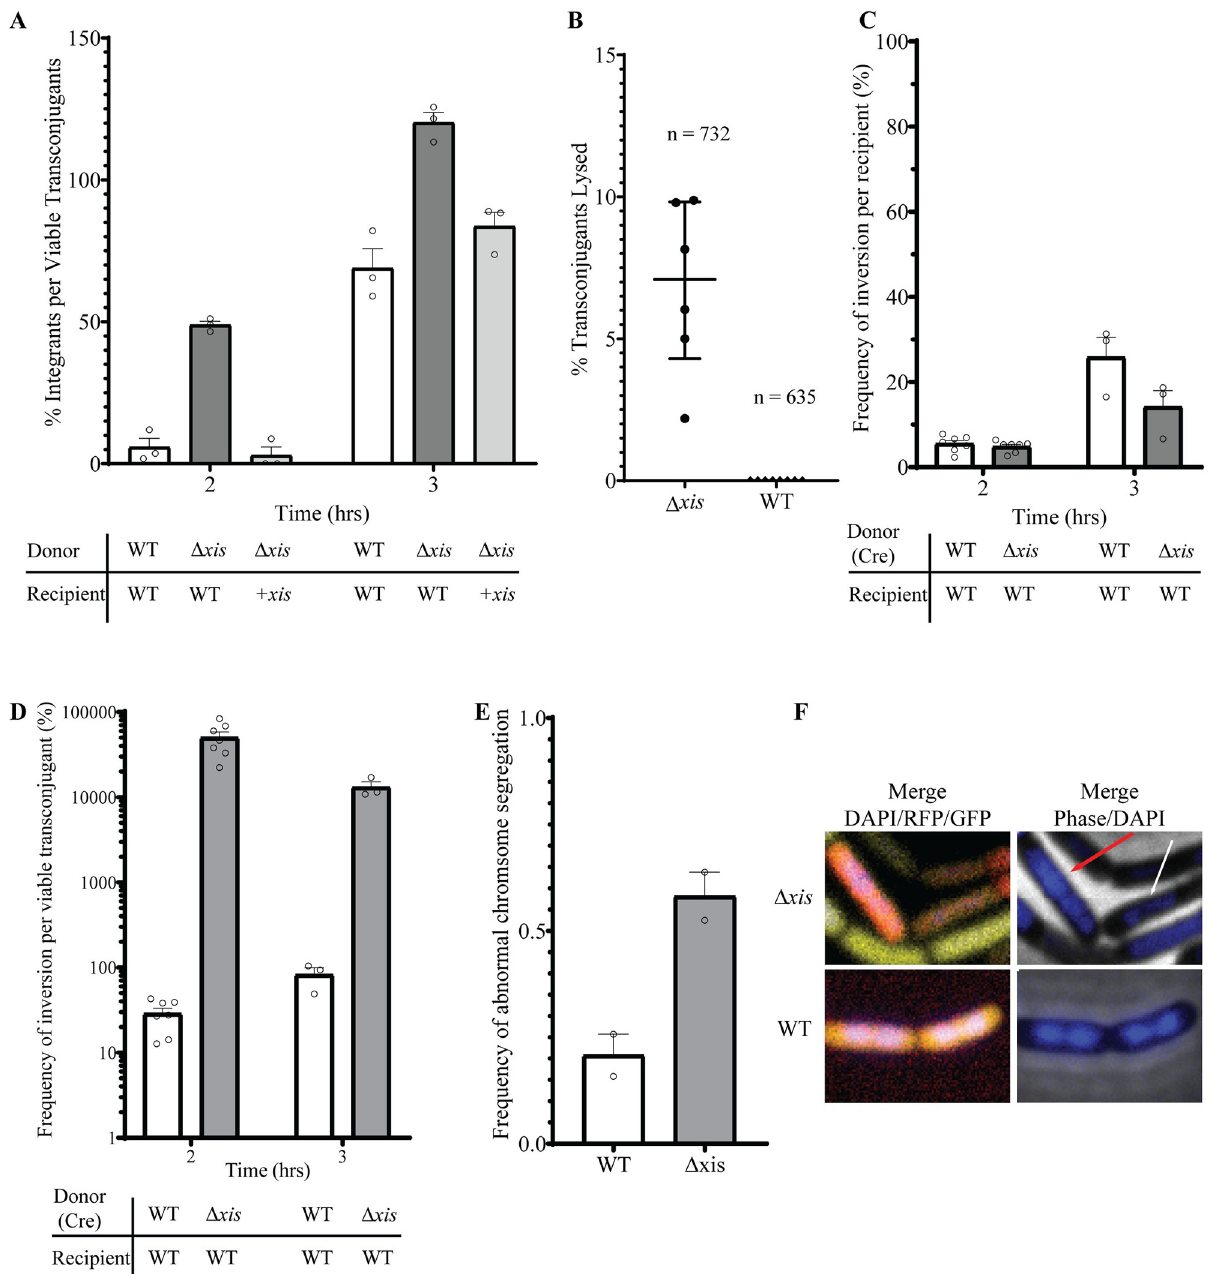
Fig 2. Early integration of ICE Bs1 causes cell death. A) Integration of ICE Bs1 in transconjugants was measured by qPCR and normalized to the number of transconjugant CFUs. The identity of the donor and recipient strains is indicated below the x-axis. Donors: WT (SAM078); Δ xis (SAM207). Recipients: WT (SAM103); + xis ( xis expressed in recipients; SAM379). Mating pairs are shown below the graph with relevant genotypes indicated. Circles indicate the results from independent experiments. Error bars indicate standard error of the mean. Results are from the averages of at least three dilutions within the linear range with three technical replicates each for cycle threshold (CT) values from PCR, then normalized to CFUs. B) Lysis of ICE Bs1 Δ xis transconjugants. Donors (ICE Bs1 Δ xis ; SAM472; or ICE Bs1 xis+ ; SAM288) harboring ICE Bs1 with constitutively expressed mNeongreen were mated with recipients (SAM271) constitutively expressing mApple (and MLS resistant) for 4 hr. Samples were then spotted onto nutrient-rich agarose pads containing erythromycin and lincomycin (selecting for recipients and transconjugants, preventing growth of donors). Transconjugants were identified by co-expression of mNeongreen and mApple . Cell fate was tracked over the course of 3 hr. Each point represents the frequency of lysed transconjugant cells in an individual field of cells from one representative experiment. Top and bottom lines indicate the interquartile range and the middle line indicates the median. We tracked 732 and 635 transconjugants from Δ xis and wild type ( xis +), respectively. Of these 51 (~7%) of the Δ xis and 1 ( � 0.2%) of the xis + transconjugants lysed during the 4 hrs of observation. C) Acquisition of ICE Bs1 as measured by Cre-mediated recombination